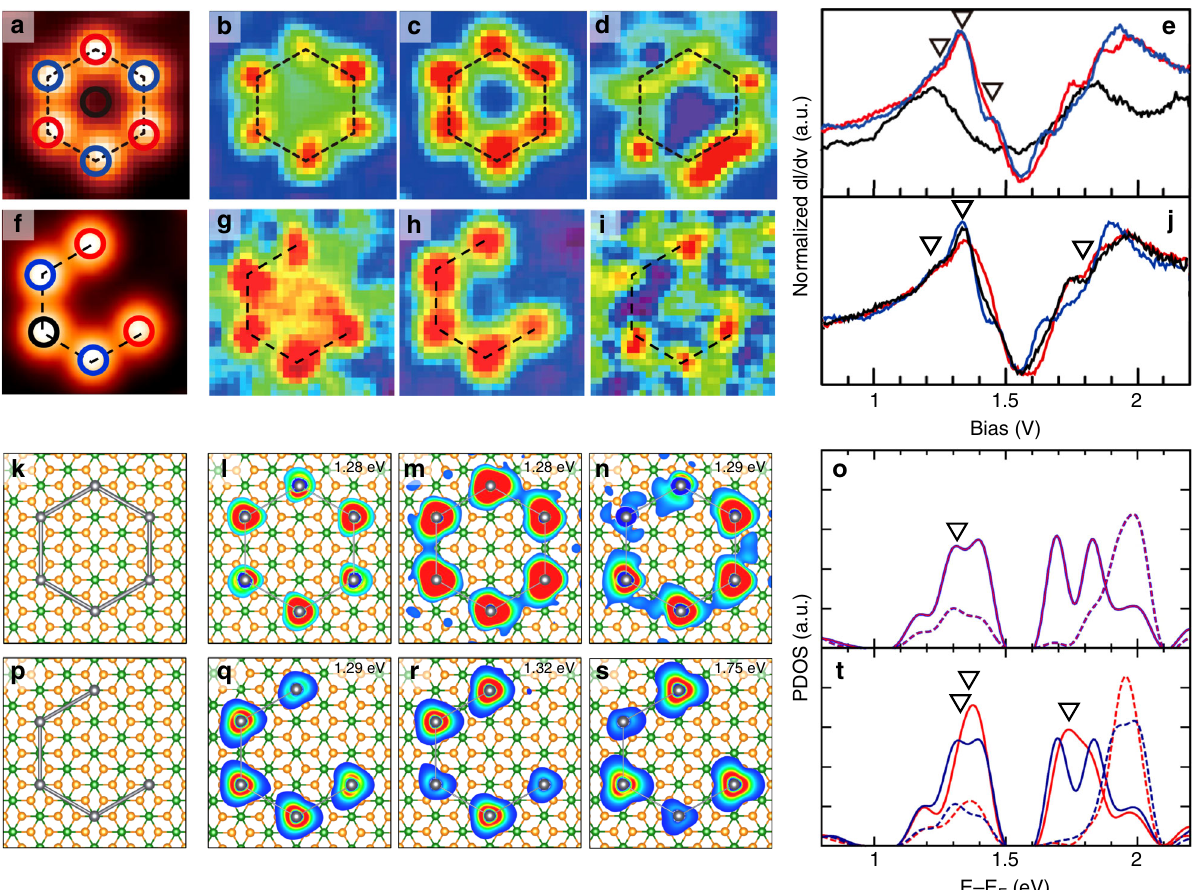
Fig. 3 Benzene-ring-shaped Pb clusters on IrTe 2 . a , f STM topography, b – d , g – i dI / dV maps, and e , j STS spectra for a Pb hexamer and a pentamer, respectively. dI / dV maps are taken at the energies indicated in the STS spectra. Red, blue, and black lines in the STS spectra are obtained at the red, blue, and black Pb atoms indicated in a and f . The corresponding theoretical results are presented in k – t . k , p Atomic structure, l – n , q – s charge densities at the given energies (spin decoupled and spin summed, respectively), and o , t projected DOS, for a Pb hexamer and a pentamer on IrTe 2 -(7 × 7), respectively. For the Pb hexamer, the localized DOS at red and blue Pb atoms is identical to each other. For the Pb pentamer, the red (dark blue) line denote the localized states at truncated end atoms (the other Pb atoms). Solid and dashed lines represent p xy and p z states,